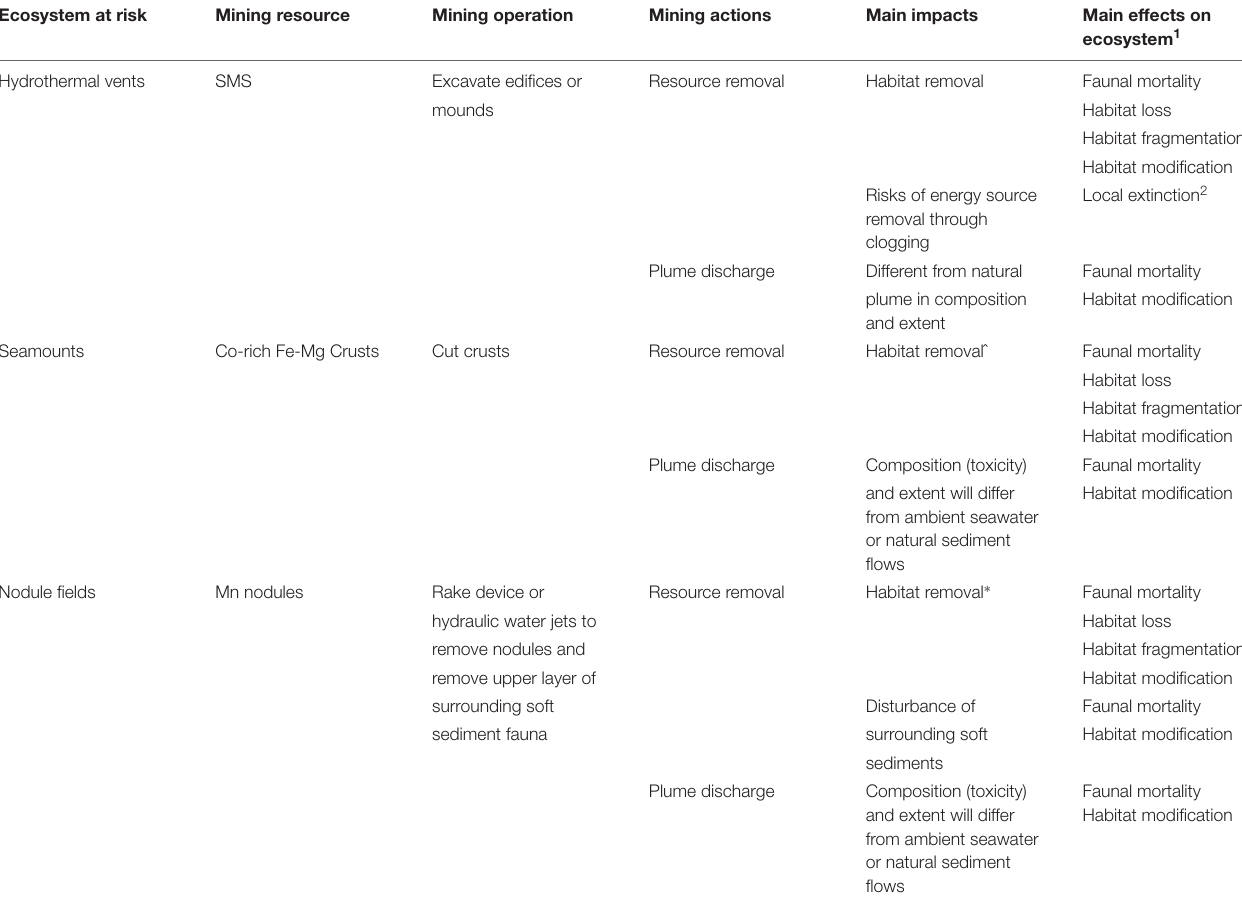
TABLE 1 | Ecosystems at risk and possible impacts of mining operations on the